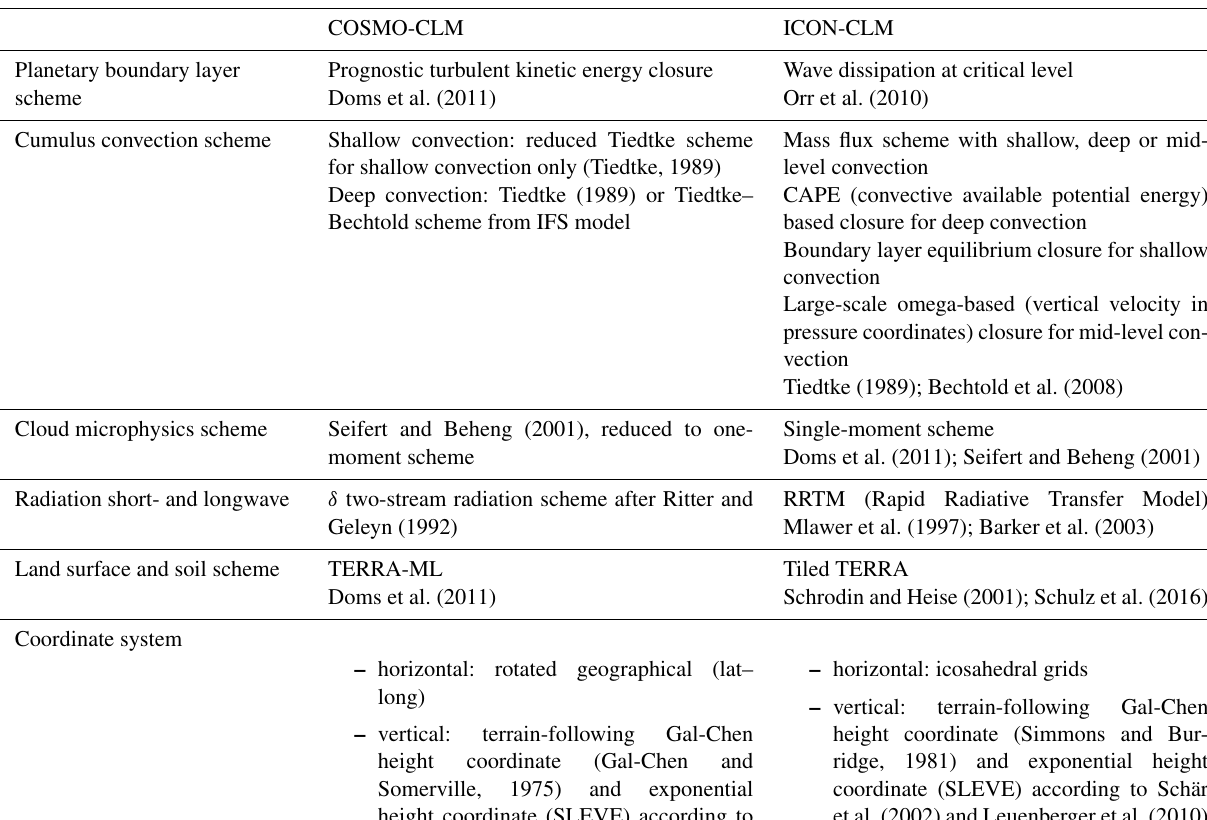
Table 2. Comparison between COSMO-CLM and ICON-CLM